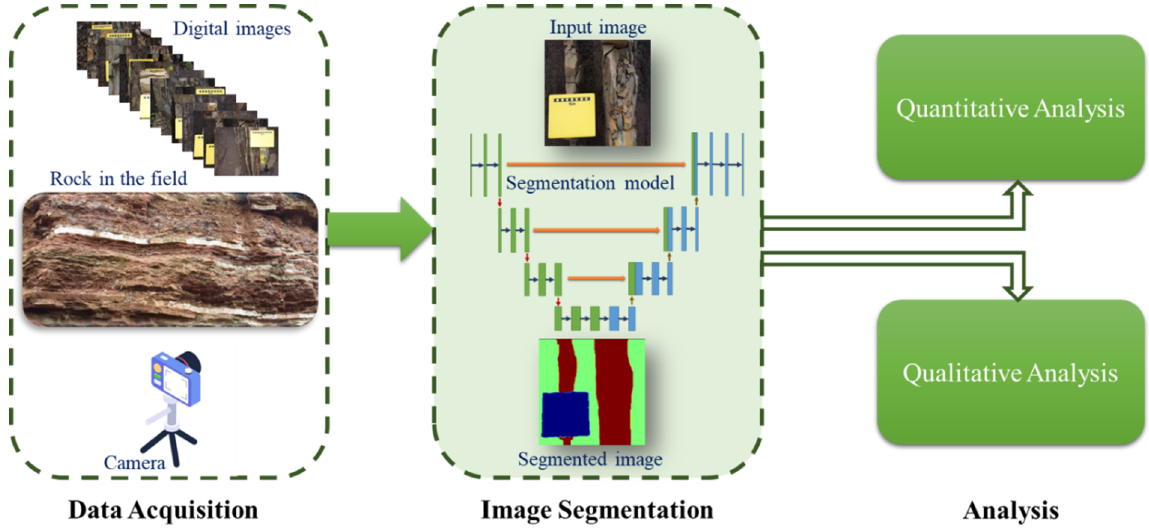
Figure 1. Overall flow of the proposed system.